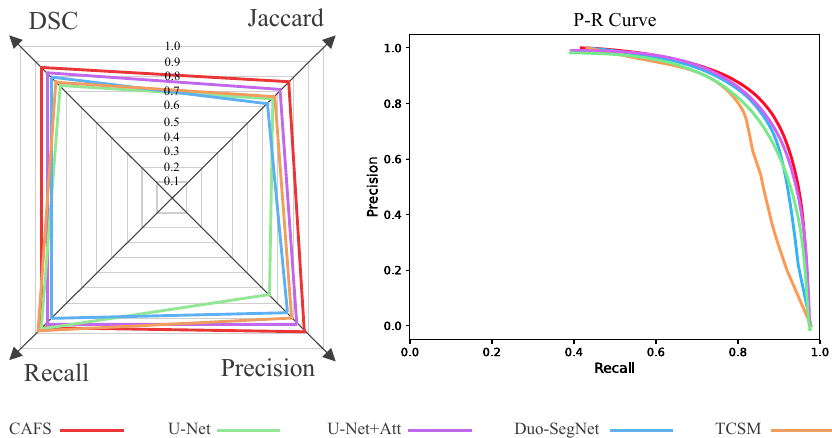
Figure 4. Radar plots and P-R curve. The radar plot is based on the four metrics of DSC, Jaccard, precision, and recall as axes. Each polygon corresponds to a model, and the four coordinate values of each model are the values of the four metrics. The closer the vertices of the polygon are to the outside, the better the model performs on the corresponding metrics. Each curve in the P-R curve corresponds to a model, and if the area enclosed under the curve is larger, it means that the corresponding model segmentation performs